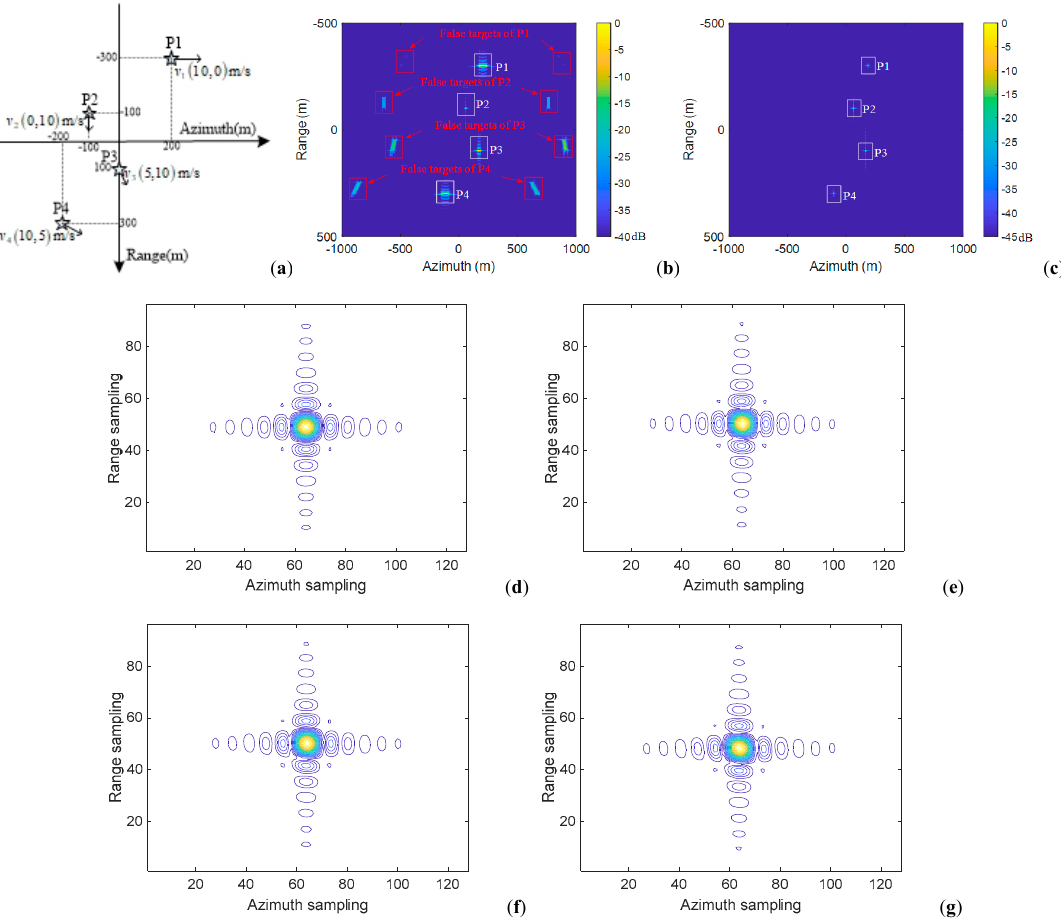
Figure 16. Imaging results of point targets. ( a ) Geometry of simulated point targets. ( b ) Conventional azimuth multichannel reconstruction. ( c ) Proposed azimuth multichannel reconstruction. Contour plots of targets 1–4. ( d ) Target P1. ( e ) Target P2. ( f ) Target P3. ( g ) Target P4. Table 4. Imaging quality parameters on simulated point targets in multichannel GEO-SA-BiSAR.